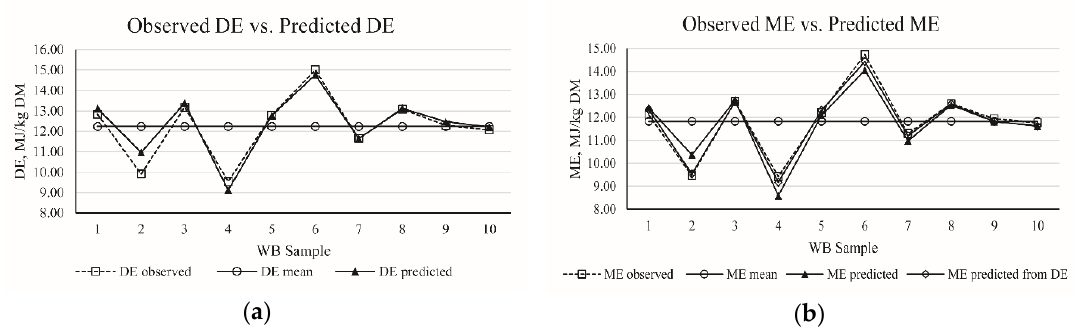
Figure 3. ( a ) The distribution of observed digestible energy (DE) of wheat bran (WB) and predicted DE of WB calculated from best-fit equation in present study; ( b ) the distribution of observed metabolism energy (ME) of WB, predicted ME of WB from DE, and predicted ME of WB calculated from the best-fit equation in present study.